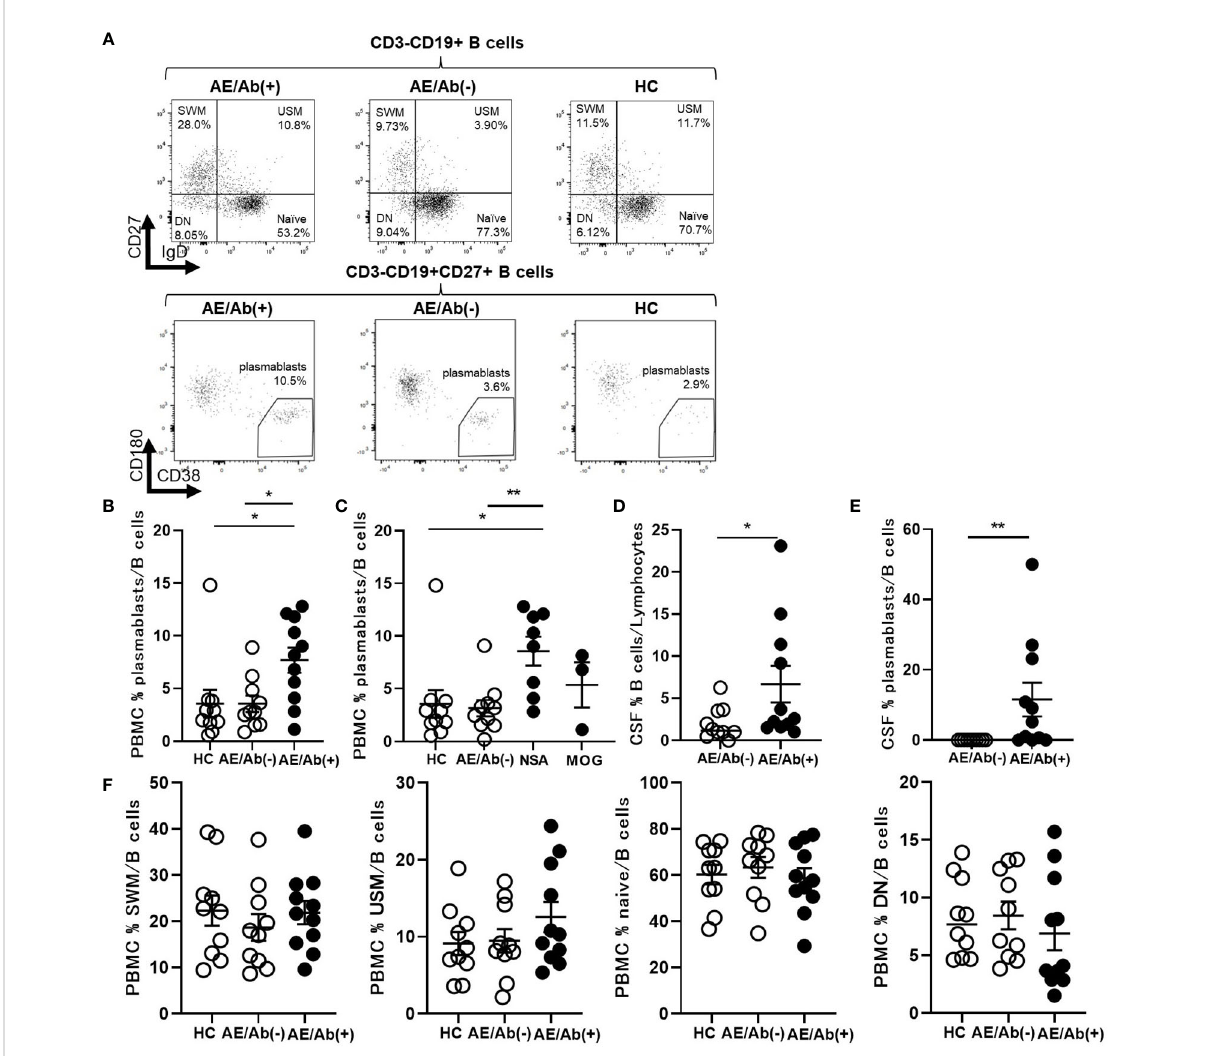
+CD27 – IgD – (DN), CD19+CD27+IgD+ (USM), CD19+CD27+IgD – (SWM), and CD19 int CD27 high CD38 high CD180 – (plasmablasts) in PBMCs of HC, patients with AE/Ab(-) and AE/Ab(+). (B, C) The frequency of plasmablasts in B cells of PBMCs of each group. NSA is de fi ned as the patients group of NMDA receptor antibody-positive autoimmune epilepsy and LGI1 antibody associated autoimmune epilepsy. (D) The frequency of B cells within lymphocytes in the CSF of patients with AE/Ab(-) and AE/Ab(+). (E) The frequency of plasmablasts within B cells in the CSF of patients with AE/Ab(-) and AE/Ab(+). (F) The frequency of SWM, USM, naive, and DN within B cells in PBMCs of each group. HC (n=11), AE/Ab(-) (n=10), and AE/Ab(+) (n=11).Values are expressed as the mean ± SEM. *p < 0.05 and **p < 0.01; two-sided unpaired t -test or Mann-Whitney U test, as appropriate. HC, healthy controls; AE/Ab(-), antibody-negative suspected autoimmune epilepsy; AE/Ab(+), antibody-positive autoimmune epilepsy; SWM, switched memory B cell; USM, unswitched memory B cell; DN, double negative B cell; naive, naive B cell; NSA, neuronal surface antigen; NMDA, N-methyl-D-aspartate; LGI1, leucine-rich glioma-inactivated 1; MOG, myelin oligodendrocyte glycoprotein; PBMCs, peripheral blood mononuclear